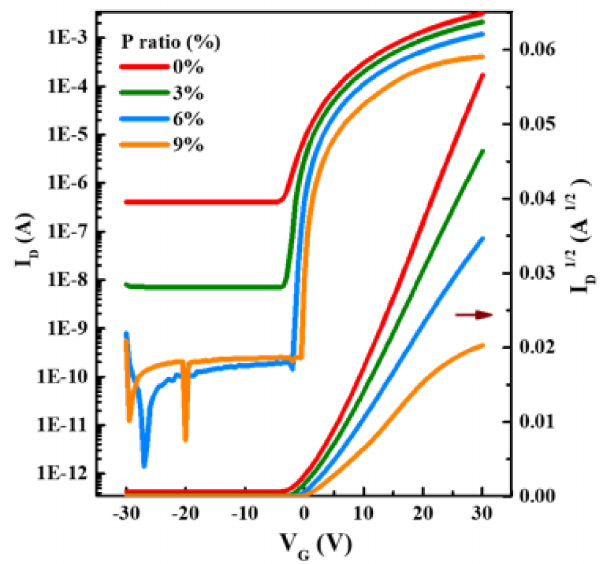
Figure 5. Transfer characteristics measured for IPO TFTs with different P ratios.